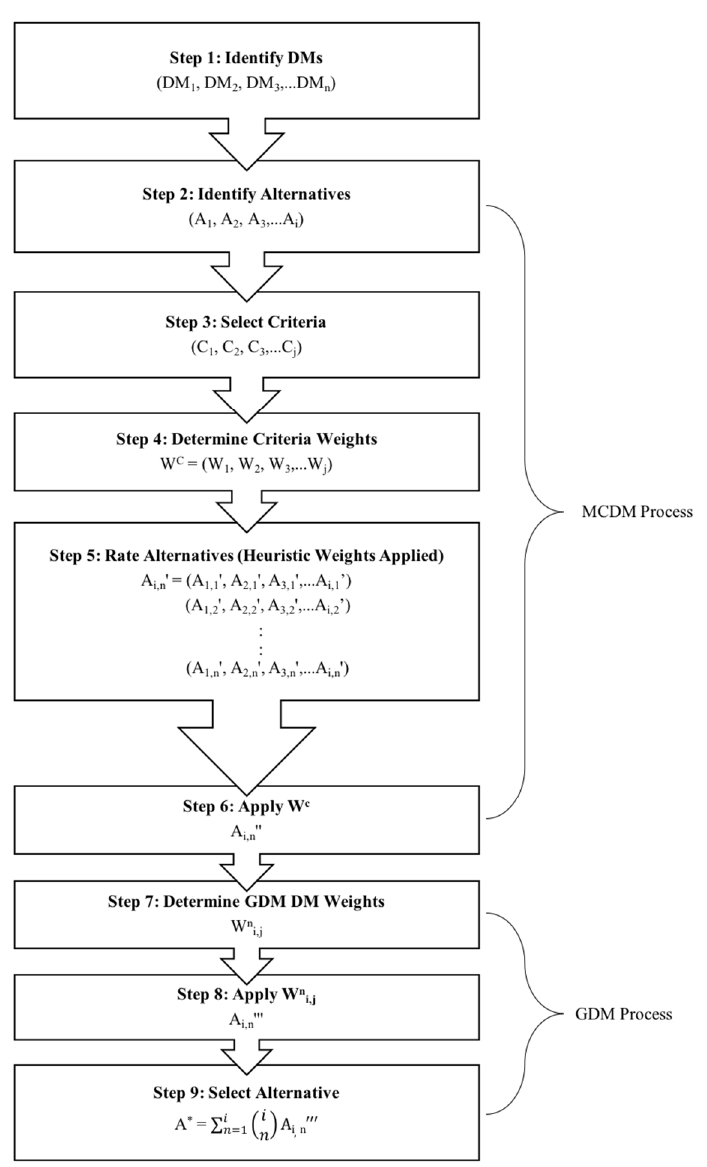
Figure 1. Multicriteria GDM process.